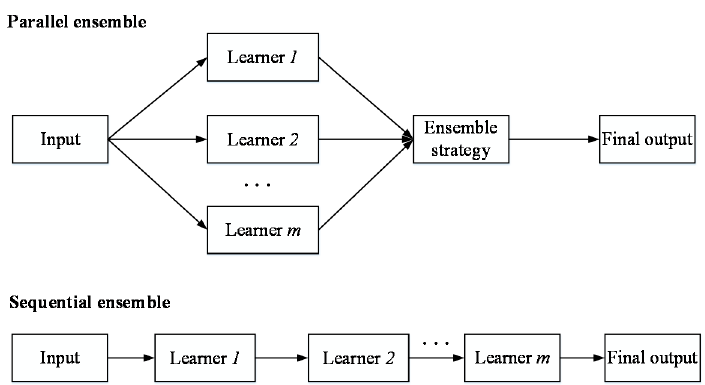
Figure 2. Flowchart of Parallel and Sequential ensemble.